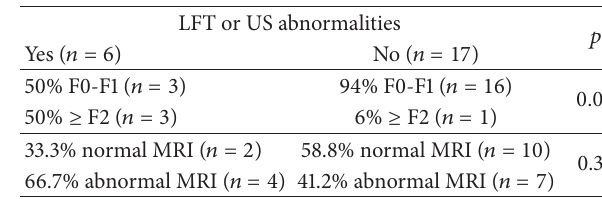
Table 3: Results of LSM and MRI according to the results of liver function tests and abdominal